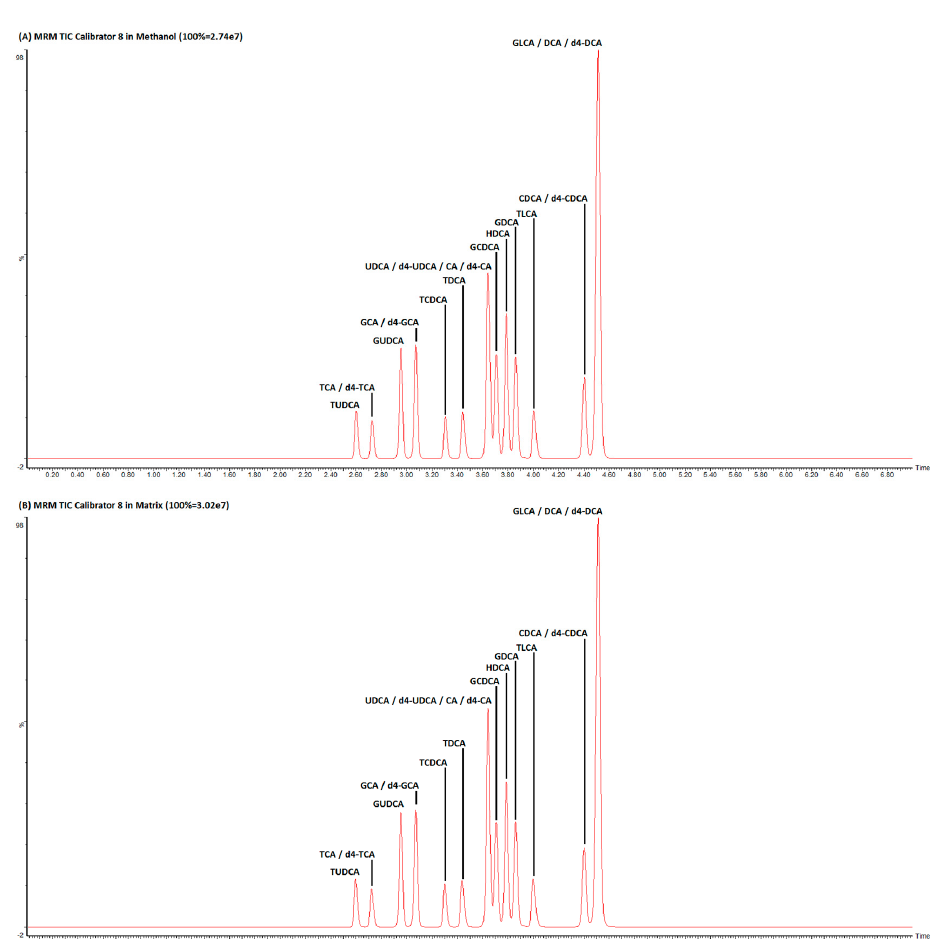
Figure 1. Representative chromatographic run of a calibrator in methanol ( A ) and synthetic serum ( B ).